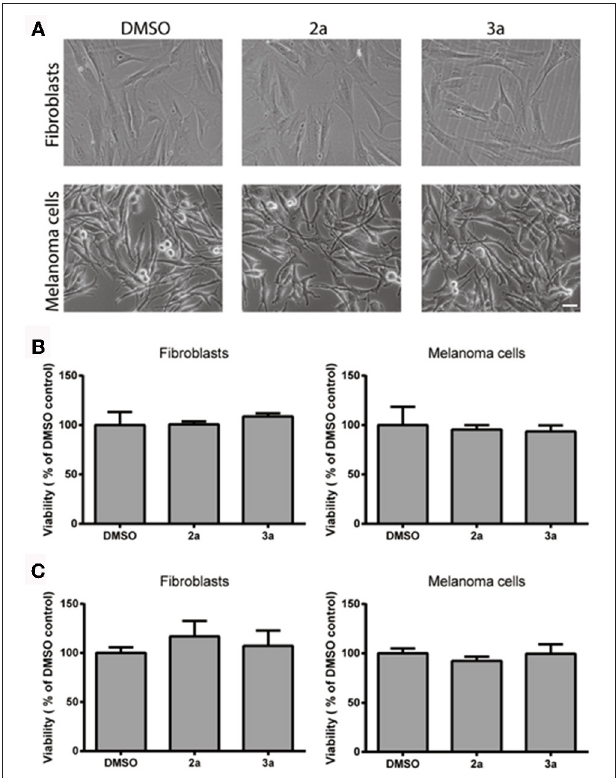
FIGURE 4 | Cell viability after staining with the thienyl-phospholes. (A) Phase contrast images of fibroblasts (AG01518) and melanoma cells (SK-MEL-28) after 48h. Scale bar = 20 µ M. (B) Cell viability, as determined by the MTT assay (B) or the crystal violet assay (C) , after 48h incubation with probes 2, 3a in fibroblasts and melanoma cells. Data was statistically analyzed with ANOVA and no significant effect on cell viability was